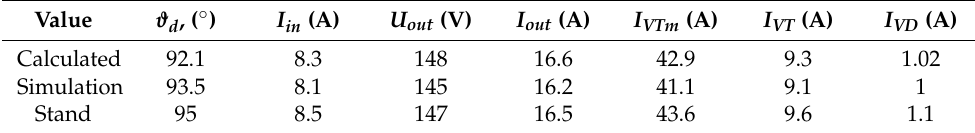
Table 4. Results from the design, the computer experiment and the practical research.